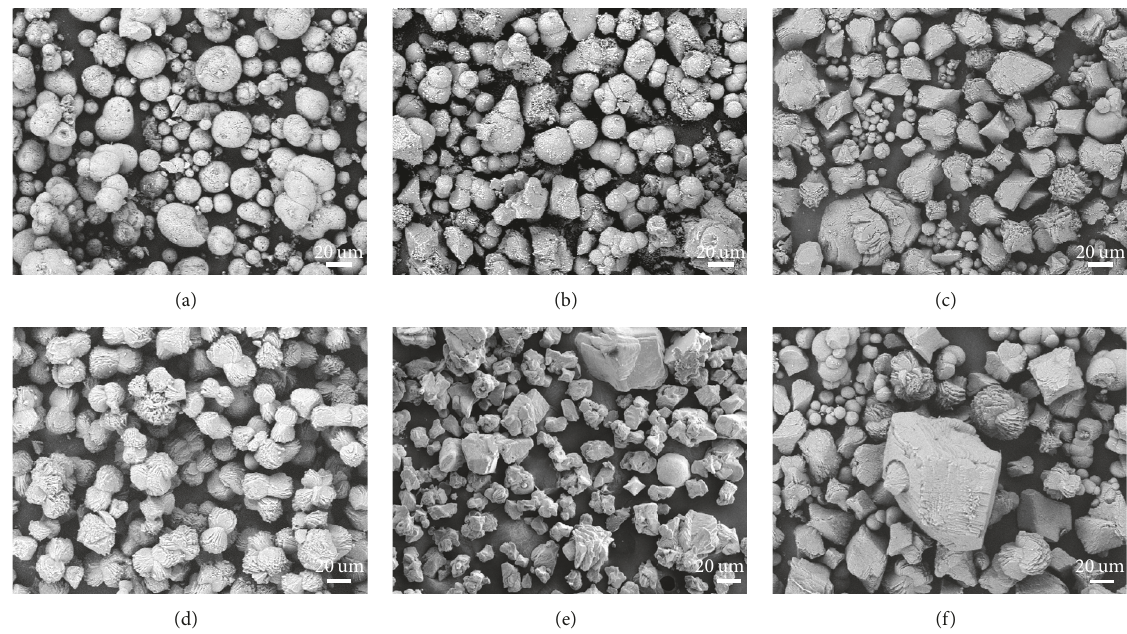
Figure 2: Typical SEM images of mineralized samples (a, b, c are mineralized samples at 0.05 mol/L Ca 2+ and 12 h, 0.1mol/L Ca 2+ and 12h, and 0.15mol/L Ca 2+ and 12 h without MMT. d, e, f are mineralized samples under the same conditions with